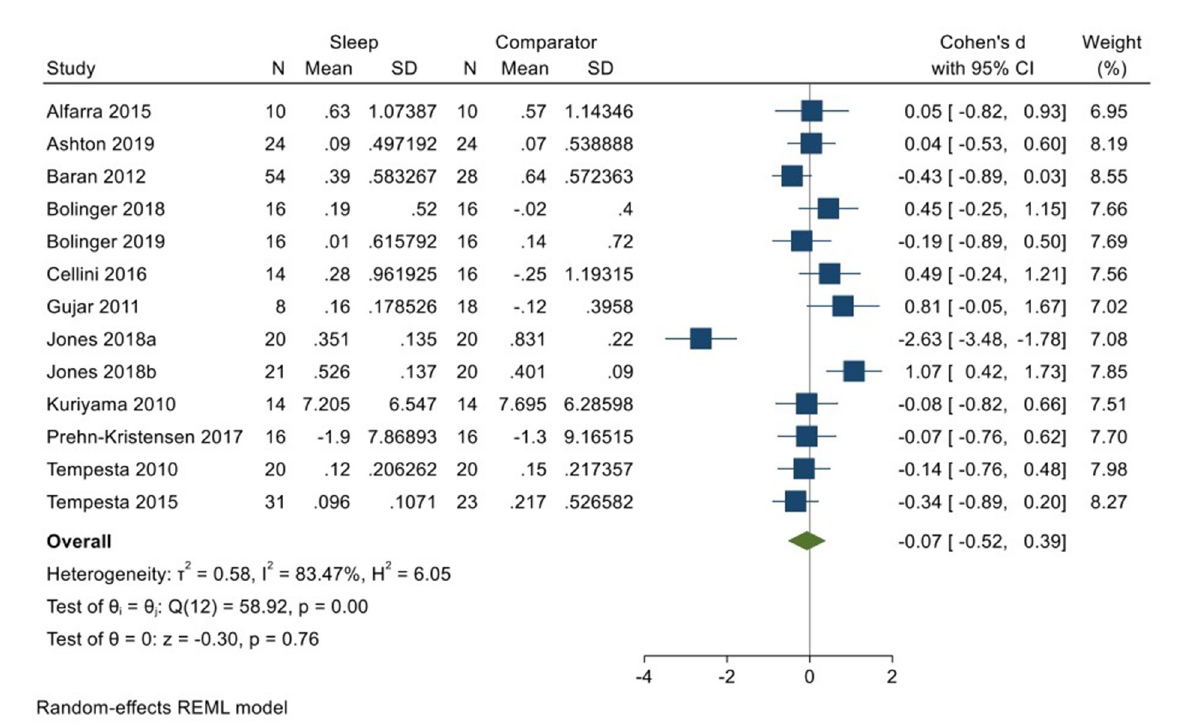
FIGURE6 Meta-analysis III: Outcomes for self-reported valence ratings in response to negative stimuli – changes across a period of sleep compared to across a period of waking ( K = 13, N =